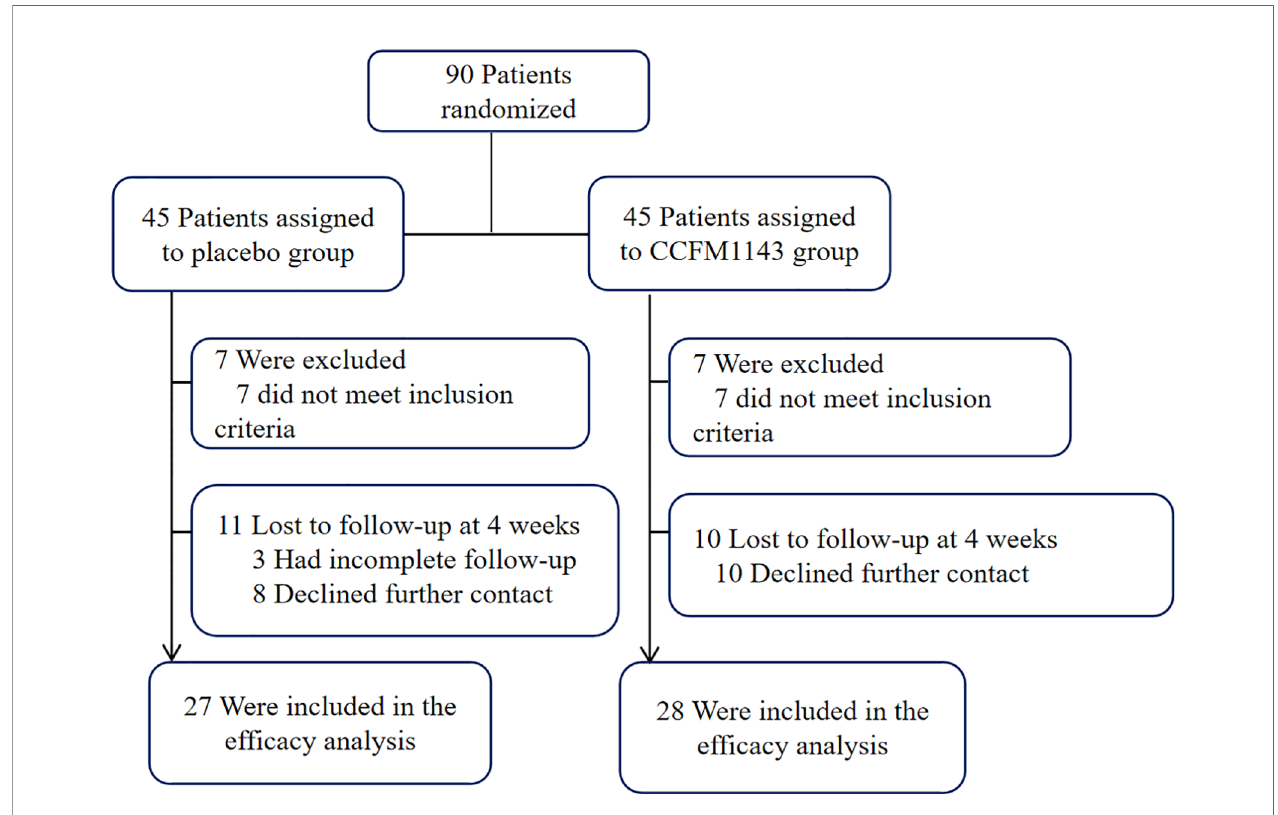
FIGURE 1 | Clinical course of Lactobacillus plantarum CCFM1143 relieving chronic diarrhea.